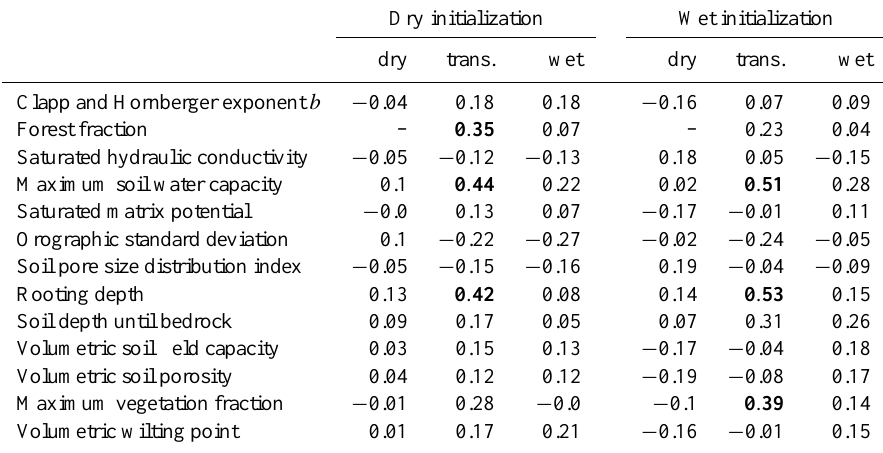
Table 3. Spatial September ensemble rank correlation coefficients between soil moisture τ 0 and static soil properties for different soil moisture regimes and initializations. Bold font indicates significant correlation ( p < 0 . 05).